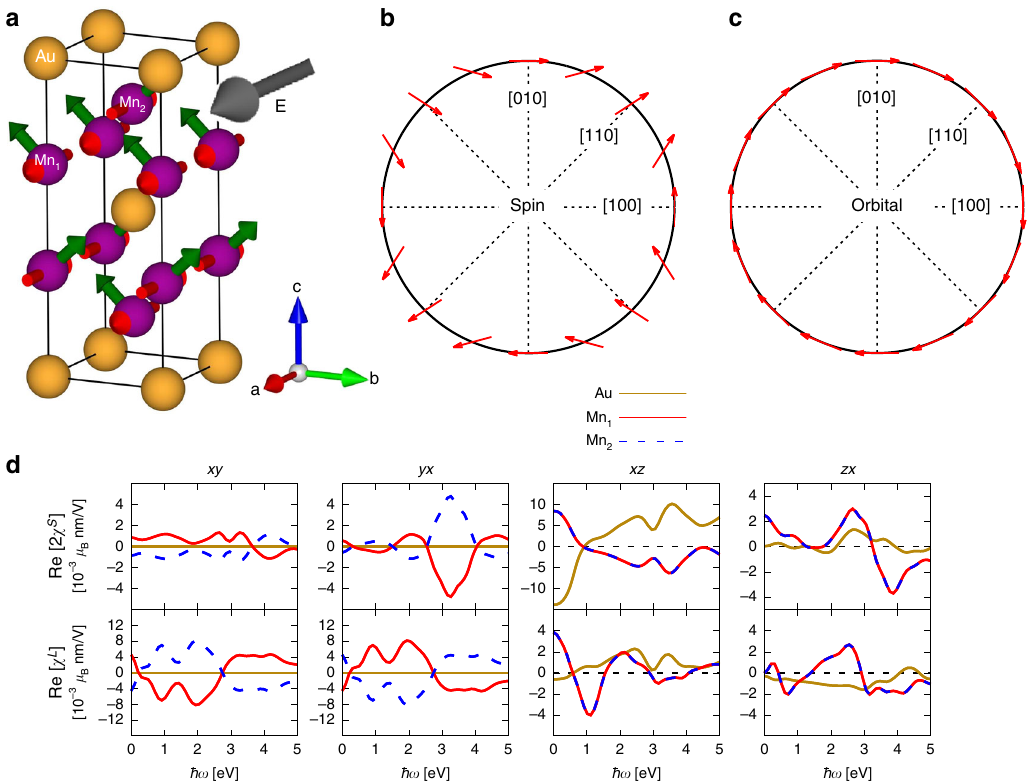
Fig. 4 Rashba-Edelstein effect in Mn 2 Au with magnetic moments along the a -axis. a The unit cell of Mn 2 Au. The red arrows on the Mn atoms represent the initial magnetic moments. Applying an electric fi eld E along the (100) direction (gray arrow) induces a nonequilibrium magnetization mainly along the (010) direction (green arrows). b In-plane symmetry of the induced spin magnetization as a function of the static electric- fi eld direction for Mn 1 . c Symmetry of the induced orbital magnetization as a function of the static electric- fi eld direction for Mn 1 . d Real parts of the nonzero tensor components ij ( i ; j ¼ x , y , or z ) of the spin and orbital Rashba-Edelstein susceptibilities, Re ½ 2 χ S (cid:5) and Re ½ χ L (cid:5) , as function of the electric- fi eld frequency, _ ω